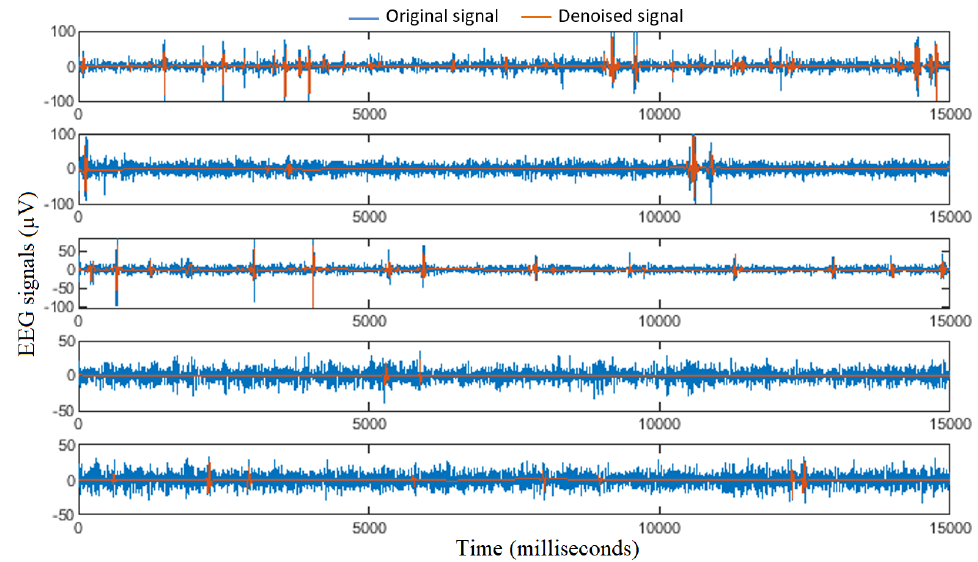
Figure 2. Illustration of EEG signals before and after artifacts’